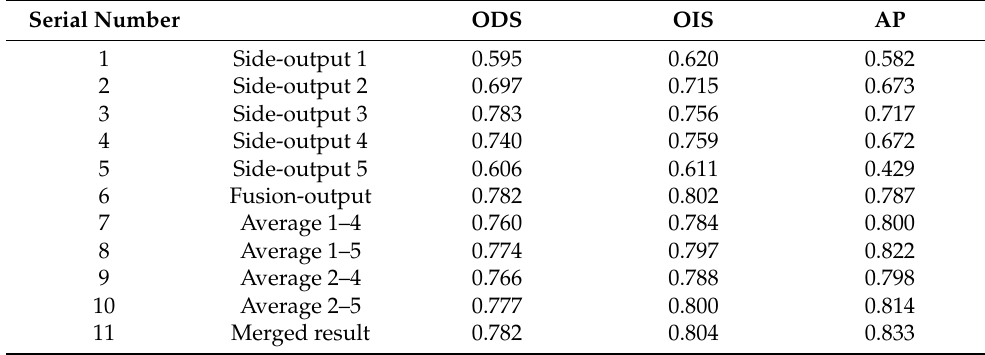
Table 1. HED detection accuracy.